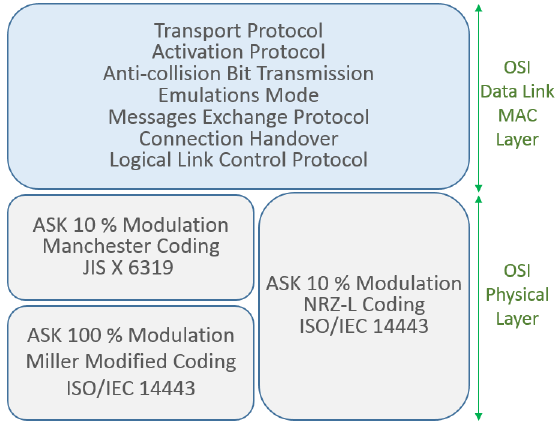
Figure 3. NFC active to passive device communication protocol stack.